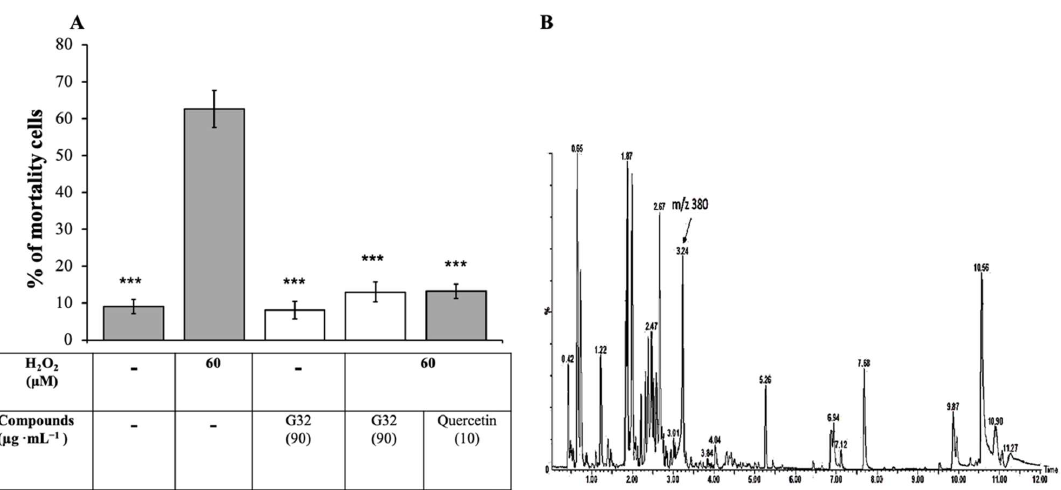
Figure 2. Cellular protective effect and LC-MS of the G32 fraction: ( A ) Protective effect of G32 fraction against artificial oxidative stress induced by H 2 O 2 on L6 muscle cells. Comparison was caried out with Quercetin as positive control. Values are the means (±SD) (***) p < 0.001); ( B ) total ion current (TIC) chromatogram of fraction G32 in positive electrospray mode.